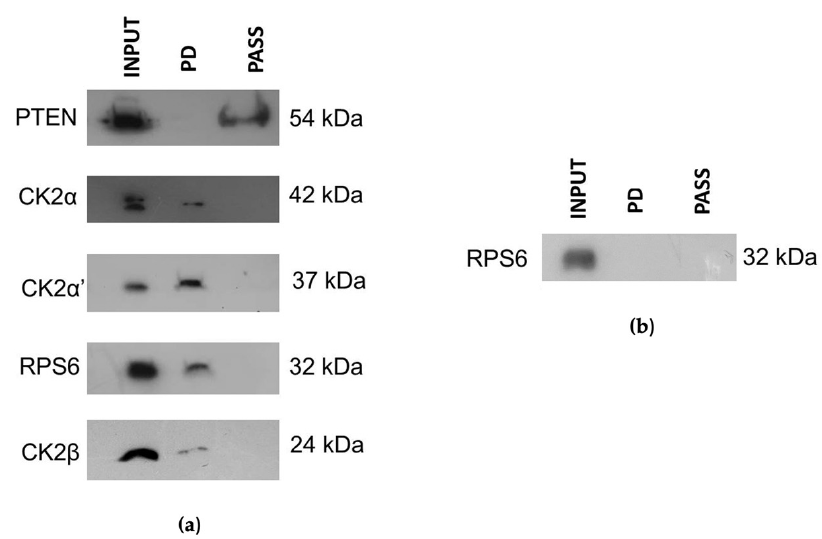
Figure 5. Pull-down in vivo assay. CIGB-300-B was added to NCI-H460 cells at a final concentration of 30 µ M and incubated for 0.5 h: ( a ) RNAase free assay; ( b ) RNAase assay for RPS6. INPUT: Cell extract. PD: Fraction interacting in pull-down reaction. PASS: Fraction not interacting in pull-down reaction.